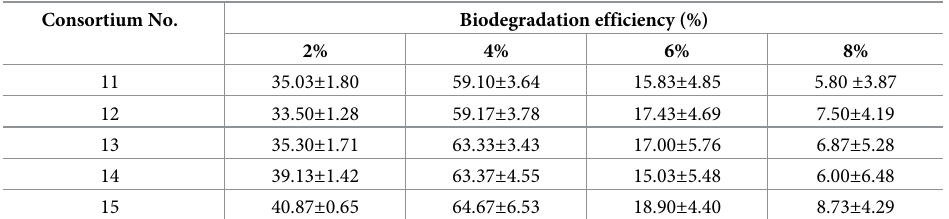
Table 12. Effect of salinity on biodegradation efficiency of crude oil of 5 fungal consortia. Consortium